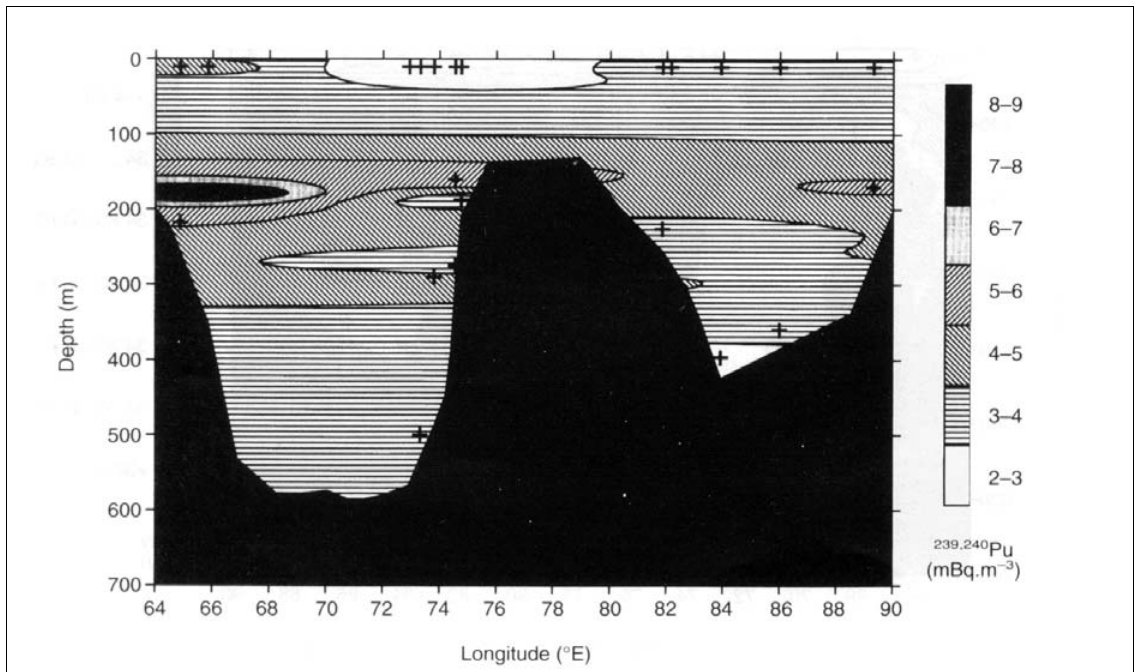
FIGURE 11 . 239/240 Pu concentrations in filtered seawater across the St. Anna/Voronin Trough[21].